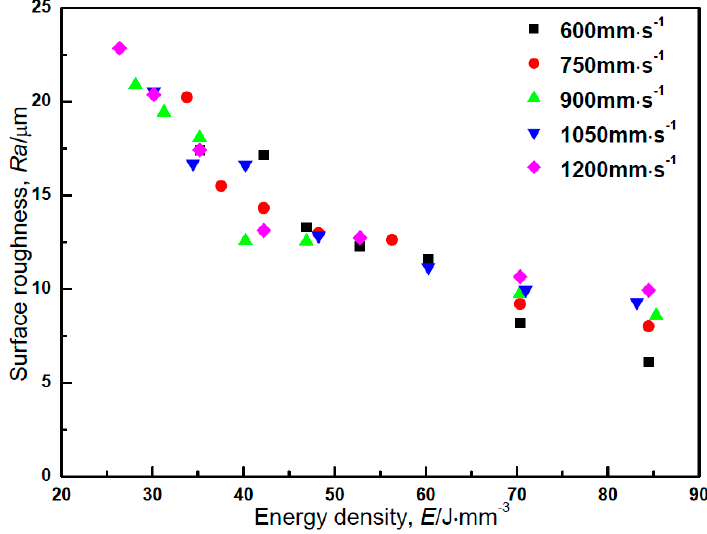
Figure 2. The top surface roughness of the as-built Zr-1Mo alloys as a function of energy density.